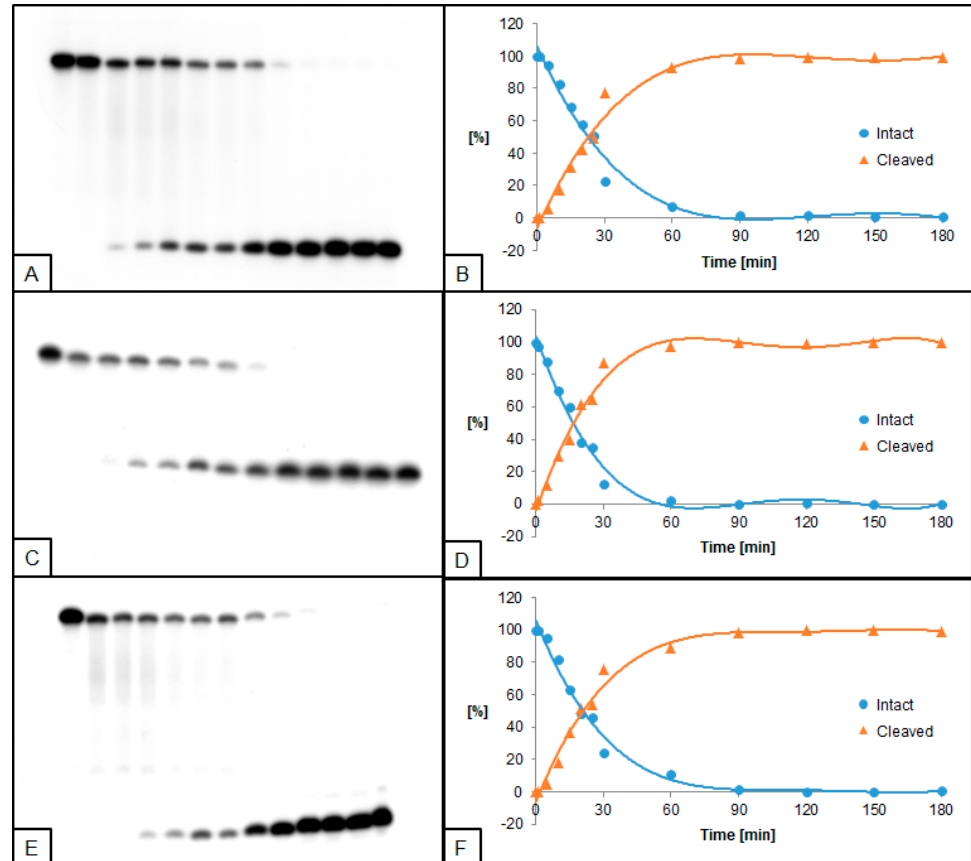
Figure 6. Cleavage of dsDNA containing dU and (5 ′ S ) − 5 ′ ,8-cyclo-2 ′ -deoxyguanosine (ScdG) by 0.5 U UDG and 0.02 U hAPE1. ( A , B ) dU( − 5)ScdG; ( C , D ) dU(+5)ScdG; ( E , F ) dU( − 5)(+5)ScdG. ( A , C , E ) show 13 lanes each, which correspond to reaction times 0, 1, 5, 10, 15, 20, 25, 30, 60, 90, 120, 150, and 180 min starting from the left. ( B , D , F ) show the quantity losses of intact ssDNA (blue) and the quantity increases of SSB-DNA (orange).